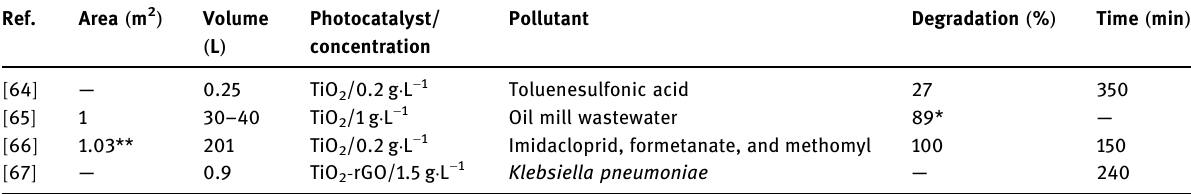
Table 2: Photocatalysis systems with the compound parabolic collector as a solar concentrator Ref.